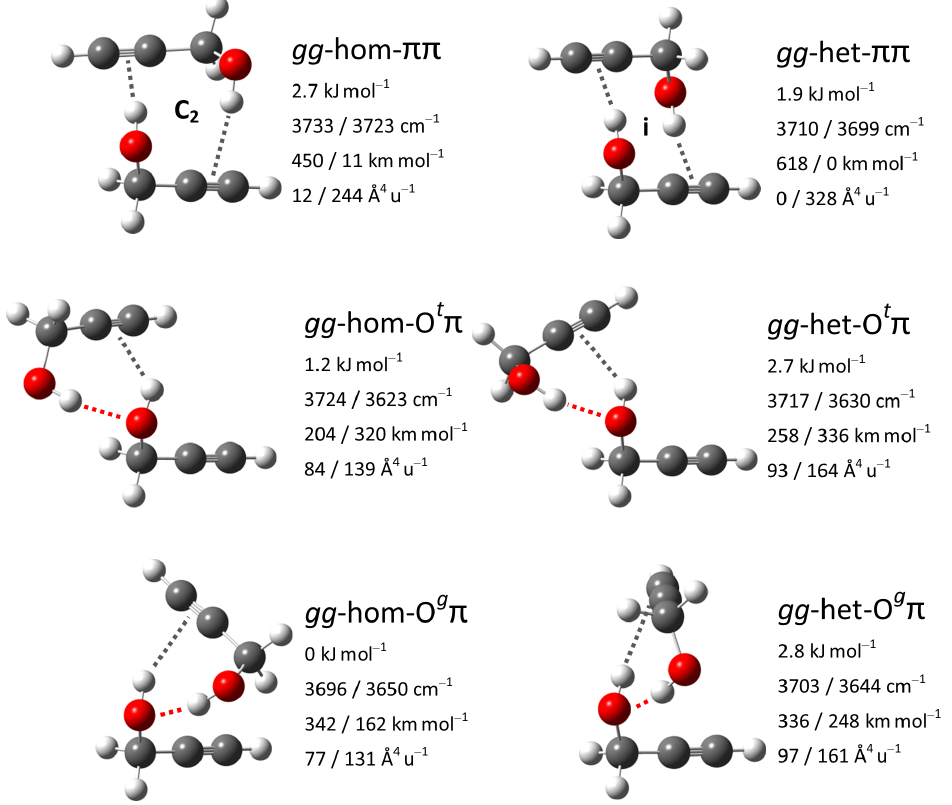
Figure 12. Leading propargyl alcohol dimer structures with harmonically zero-point-corrected relative energies, unscaled harmonic OH stretching wavenumbers as well as associated IR intensities and Raman activities at B3LYP-D3(BJ)/may-cc-pVTZ level. Indicated, where present, are symmetry elements as well as OH · · · O hydrogen bonds by red and OH · · · π by gray dotted